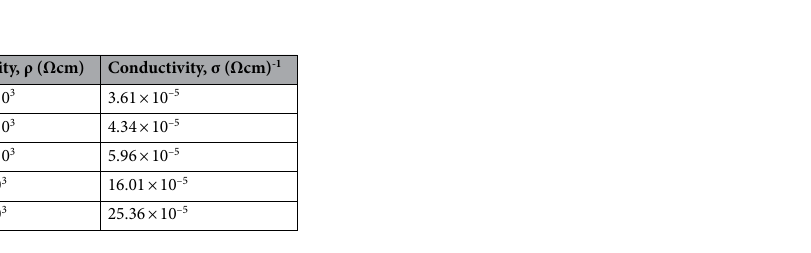
Table 2. Resistivity and conductivity data of the CdMnTe layers CdCl 2 -treated at different temperatures.